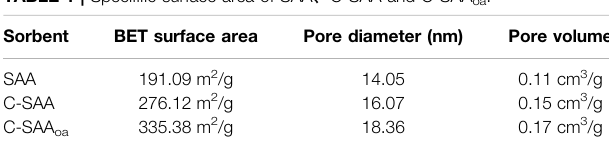
TABLE 1 | Speci fifi c surface area of SAA 、 C-SAA and C-SAA oa .